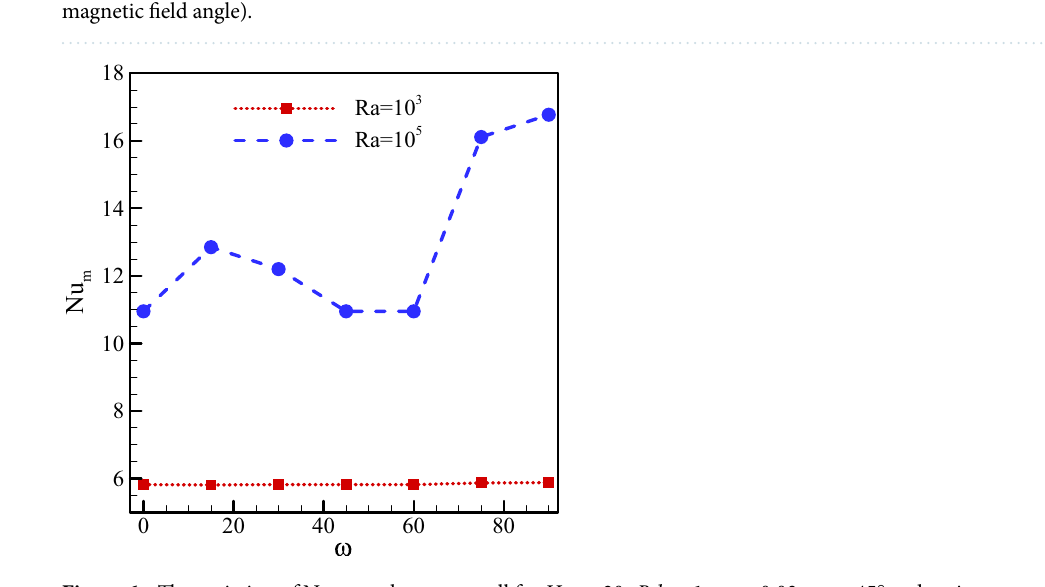
Figure 6. The variation of Nu ave on the warm wall for Ha = 20, Rd = 1, ϕ = 0.03, γ = 45 ◦ and various Rayleigh numbers and magnetic field